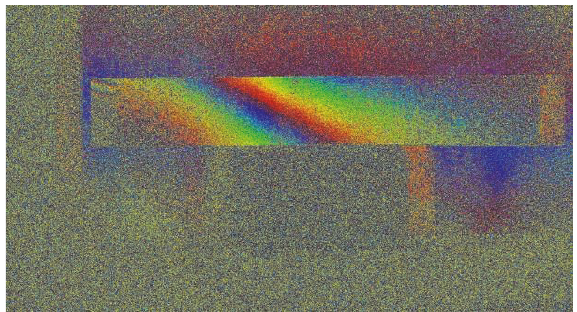
Figure 4: Shearography image of defect free sample.